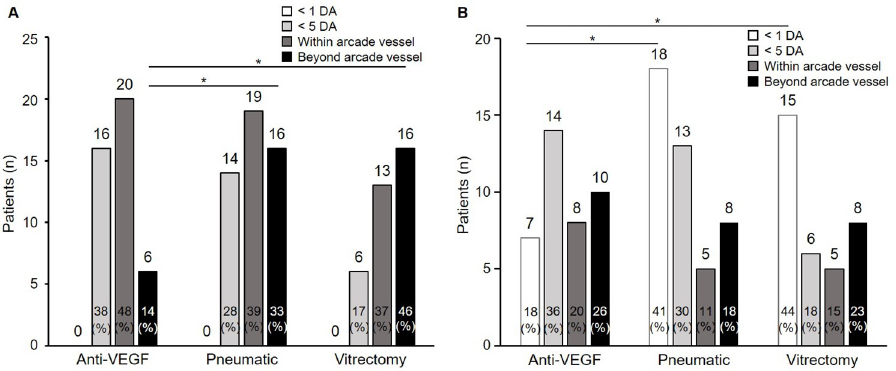
Fig 3. The sizes of the submacular hemorrhages (SMHs) based on the initial treatment before and 1 month after the initial treatment. A: The percentage of larger SMHs was higher in the vitrectomy group than in the anti-vascular endothelial growth factor (VEGF) monotherapy and pneumatic displacement groups ( � P < 0.01 Fisher’s exact test). B: The percentages of patients with a SMH reduction within 1 disc area (DA) were significantly higher with pneumatic displacement and vitrectomy than with anti-VEGF monotherapy ( P < 0.01, Fisher’s exact test). Pneumatic = pneumatic displacement.